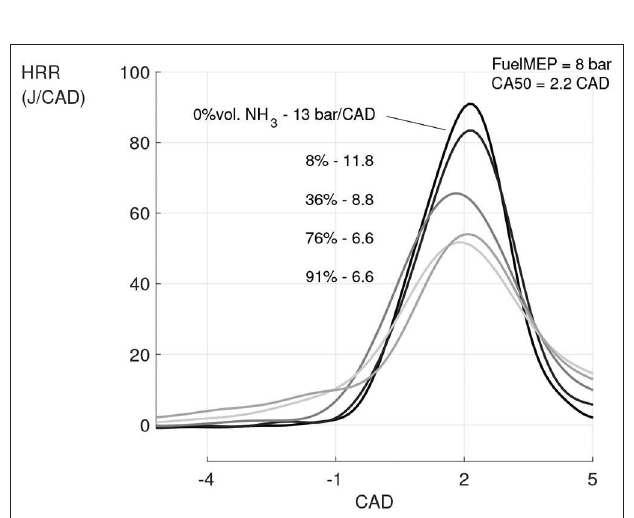
FIGURE 9 | HRR evolution for set #2 having constant FuelMEP and CA50 as the ammonia fraction is increased from 0 to 91%vol. The maximum HRR and MPRR are reduced by half and the combustion start and end are getting further apart.